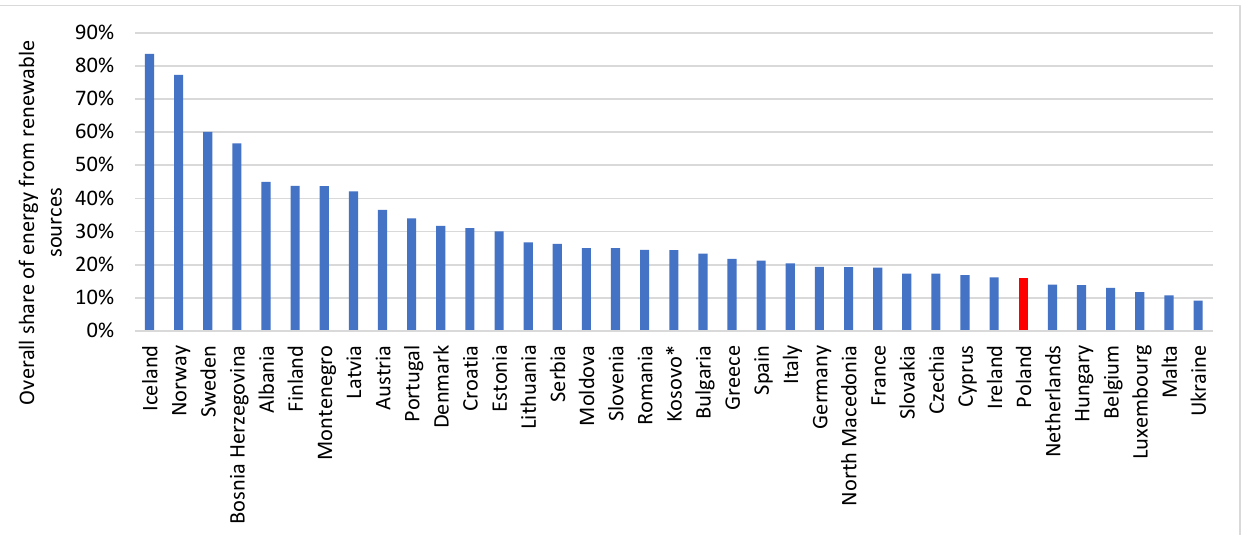
Figure 6. Overall share of energy from renewable sources in 2020 (%) in selected European countries. Source: own elaboration on the basis of data from https://ec.europa.eu/eurostat/web/energy/data/shares, accessed on 11 November 2022. Table 3. Share of RES in total production of electricity and share of main RES sources in total RES in European countries in 2020. Source: own elaboration on the basis of data from https://ec.europa.eu/eurostat/web/energy/data/shares, accessed on 11 November 2022.